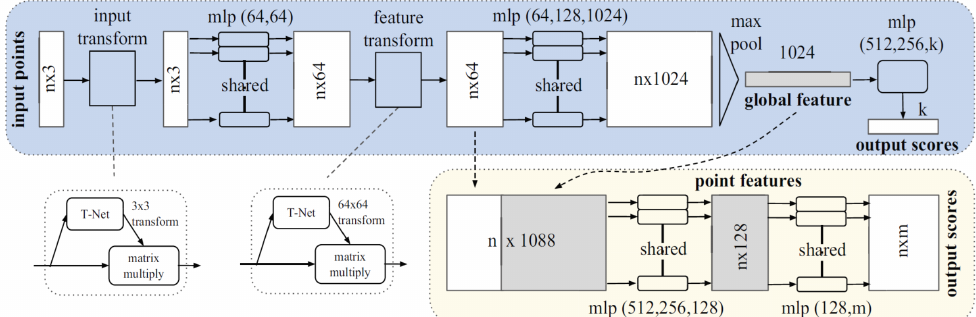
Figure 7. The network structure of